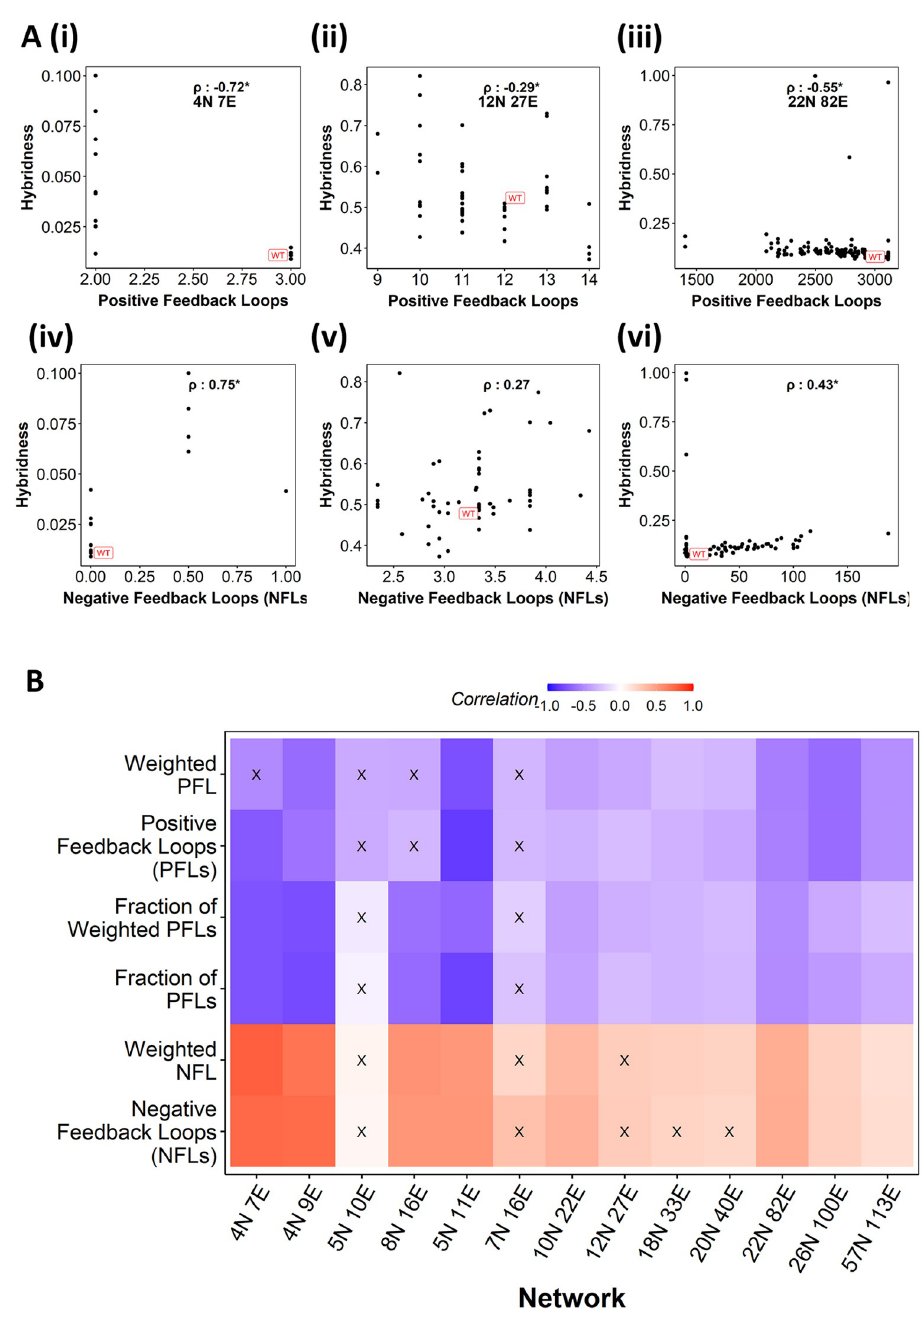
Fig 5. Positive feedback loops correlate with hybridness better than negative feedback loops. (A) Representative scatter plots between positive feedback loops (PFLs) and hybridness (i–iii). Representative scatter plots between negative feedback loops (NFLs) and hybridness (iv–vi). Each dot is a perturbed network Spearman correlation coefficient is reported. (B) Heat map depicting the spearman correlation between Hybridness and (from top to bottom) weighted PFLs, PFLs, fraction of weighted PFLs, fraction of PFLs, weighted NFLs, and NFLs. “X”: p- value > 0.05.